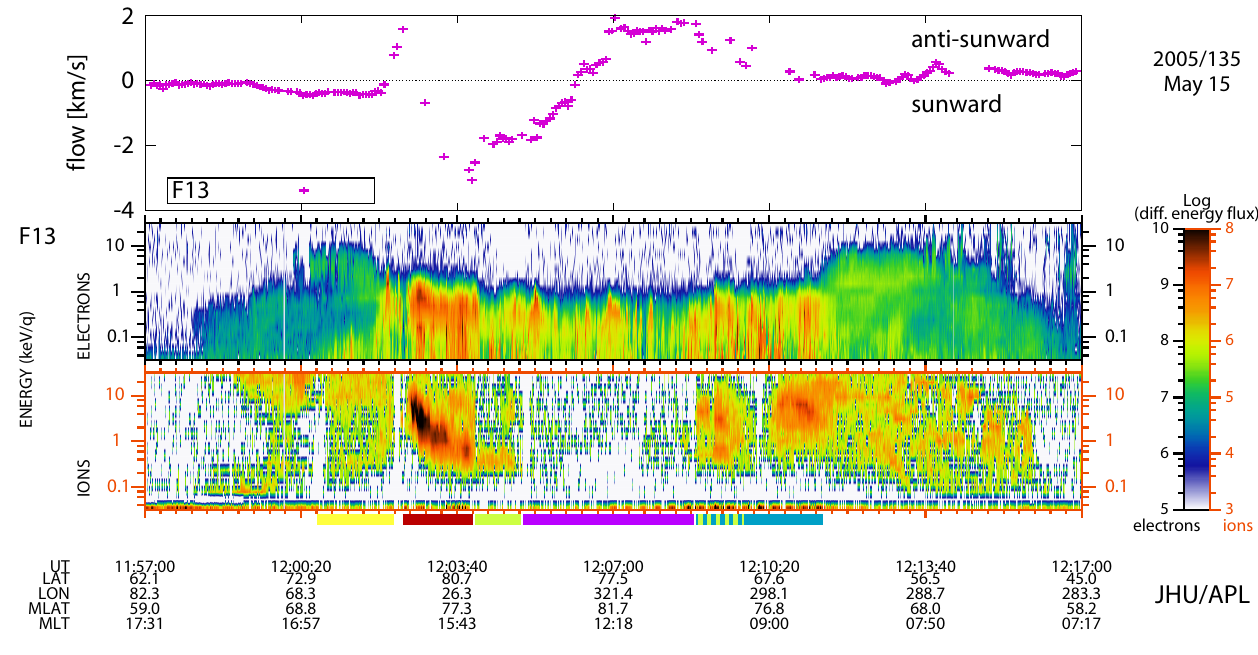
Fig. 8. Sunward/anti-sunward flow (top) and energy-time spectrograms (bottom two panels) of electrons and ions obtained by the DMSP F13 satellite from 11:57 to 12:17UT. The meaning of the bottom colour bars is the same as in Fig. 9.